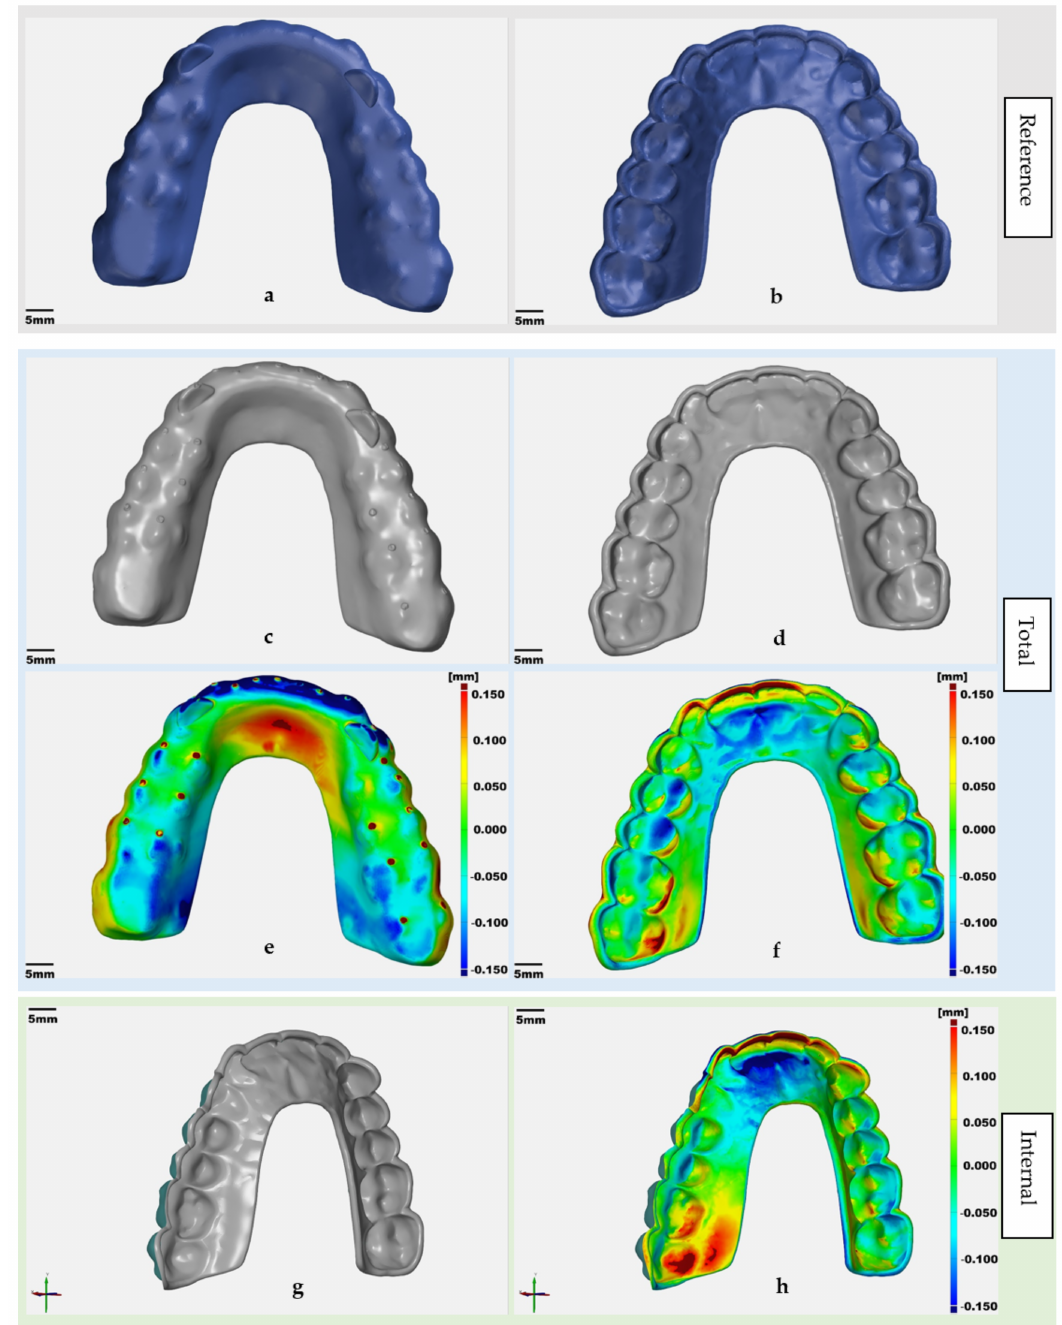
Figure 1. Reference file with ( a ) external and ( b ) internal surfaces; test file [TOTAL] with ( c ) external, ( d ) internal surfaces and the respective color-coded surface after comparison with the reference file (Scale ± 150 µ m) ( e , f ); ( g ) test file [INTERNAL] and the respective surface comparison with the reference file (Scale ± 150 µ m) ( h